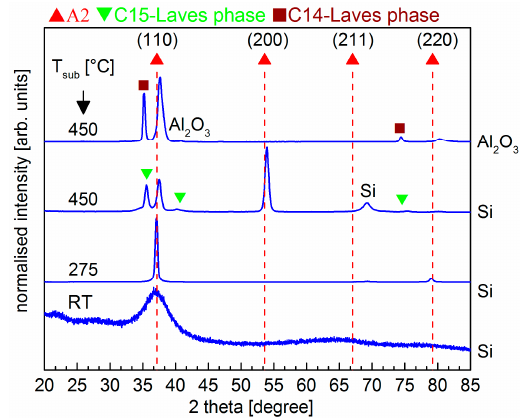
Figure 1. θ –2 θ diffractograms of HfNbTiVZr thin films prepared with substrate temperature (T sub ) = room temperature (RT), 275, and 450 ◦ C. The T sub values correspond to homologous temperature values of 0.17, 0.31, and 0.41. Red upward triangular markers with dashed vertical lines indicate the positions for a bcc phase with a lattice parameter of 3.42 Å.